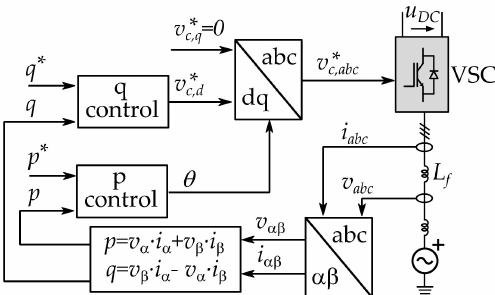
Figure 7. Scheme of the proposed virtual synchronous machine (VSM)